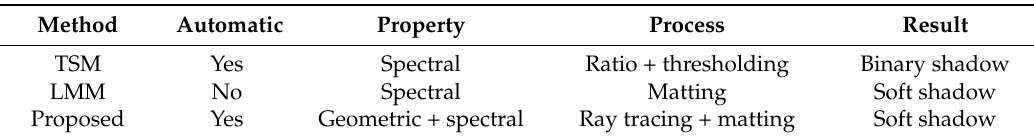
Table 1. The comparative methods used in this paper.